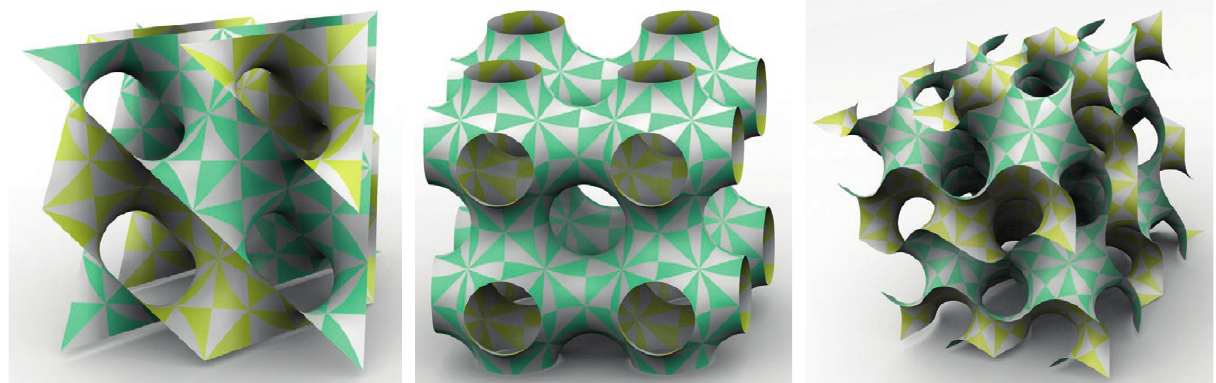
Figure 12. (Left to right) Portions of the D-surface, the P surface and the gyroid. Figure courtesy Myfanwy